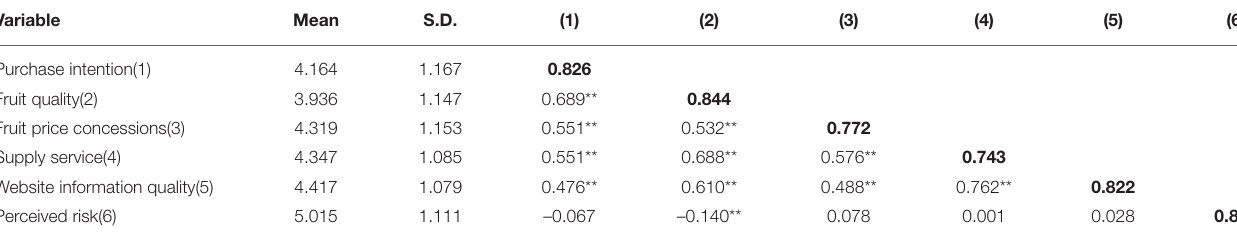
TABLE 3 | Means, SD, and interrelations of variables.